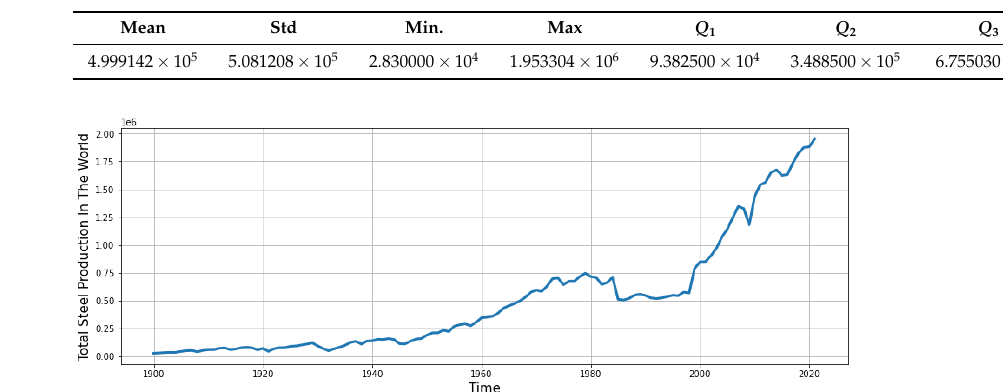
Table 1. Characteristics of the variable annual crude steel production in the world. std is the standard deviation, Q 1 is the 25% percentile, Q 2 is the 50% percentile, Q 3 is the 75% percentile. Max is the maximum value, Min the minimum value and Mean the average value.